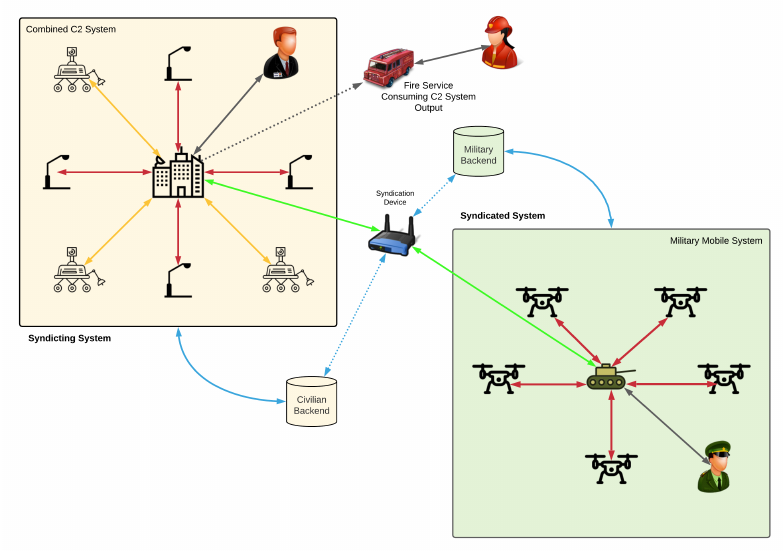
Figure 5. An example of syndication in action—showing how output from a restricted-access system can be syndicated with existing fixed, and mobile sensors.